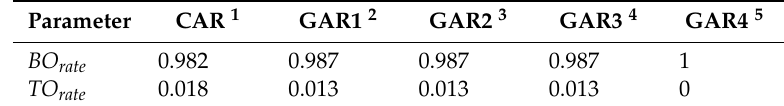
Table 6. Biological output (BO) and technological output (TO) rates for the five artificial reefs analysed in this study.